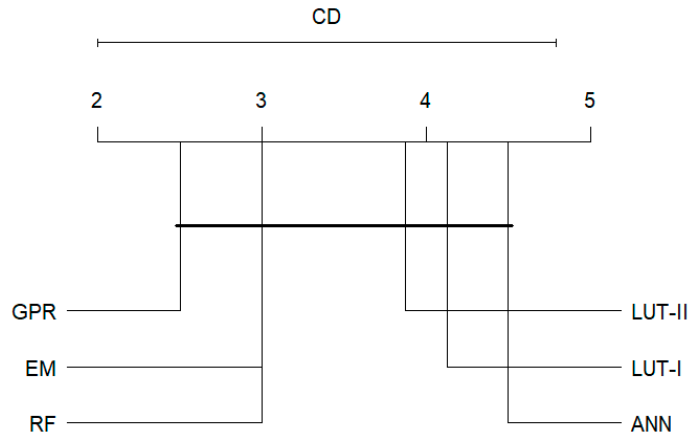
Figure 9. Critical distance diagram of the inversion methods performance for LCC estimation. The groups of the inversion methods that are not significantly different are connected with the black line ( p -value > 0.05).